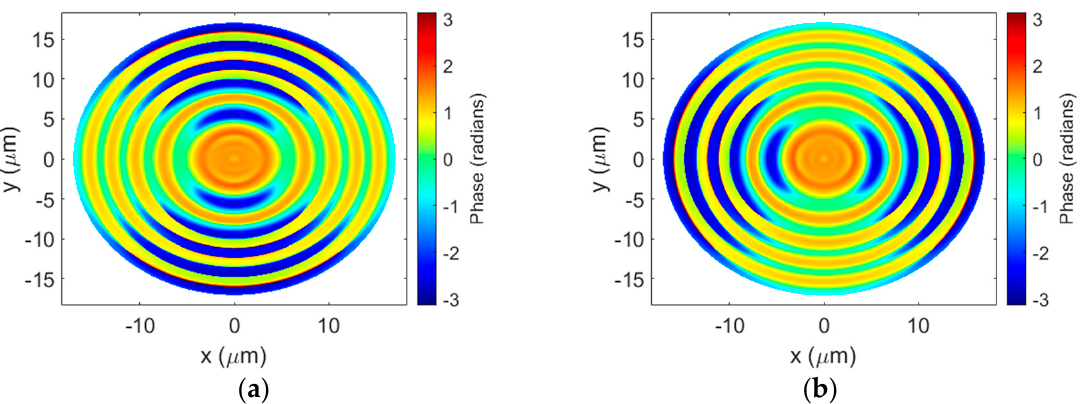
Figure 5. Near-field phase distributions of the ( a ) x -polarized and ( b ) y -polarized transmitted beams. The BPFZP is illuminated with a linearly polarized Gaussian beam propagating through the lens in the z -direction.